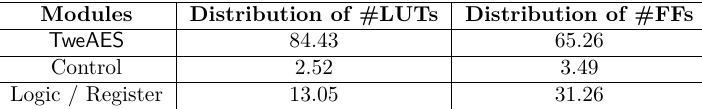
Table 12: Distribution of #LUTs (left) and #FF (right) for ESTATE_TweAES implemen- tation Modules Distribution of